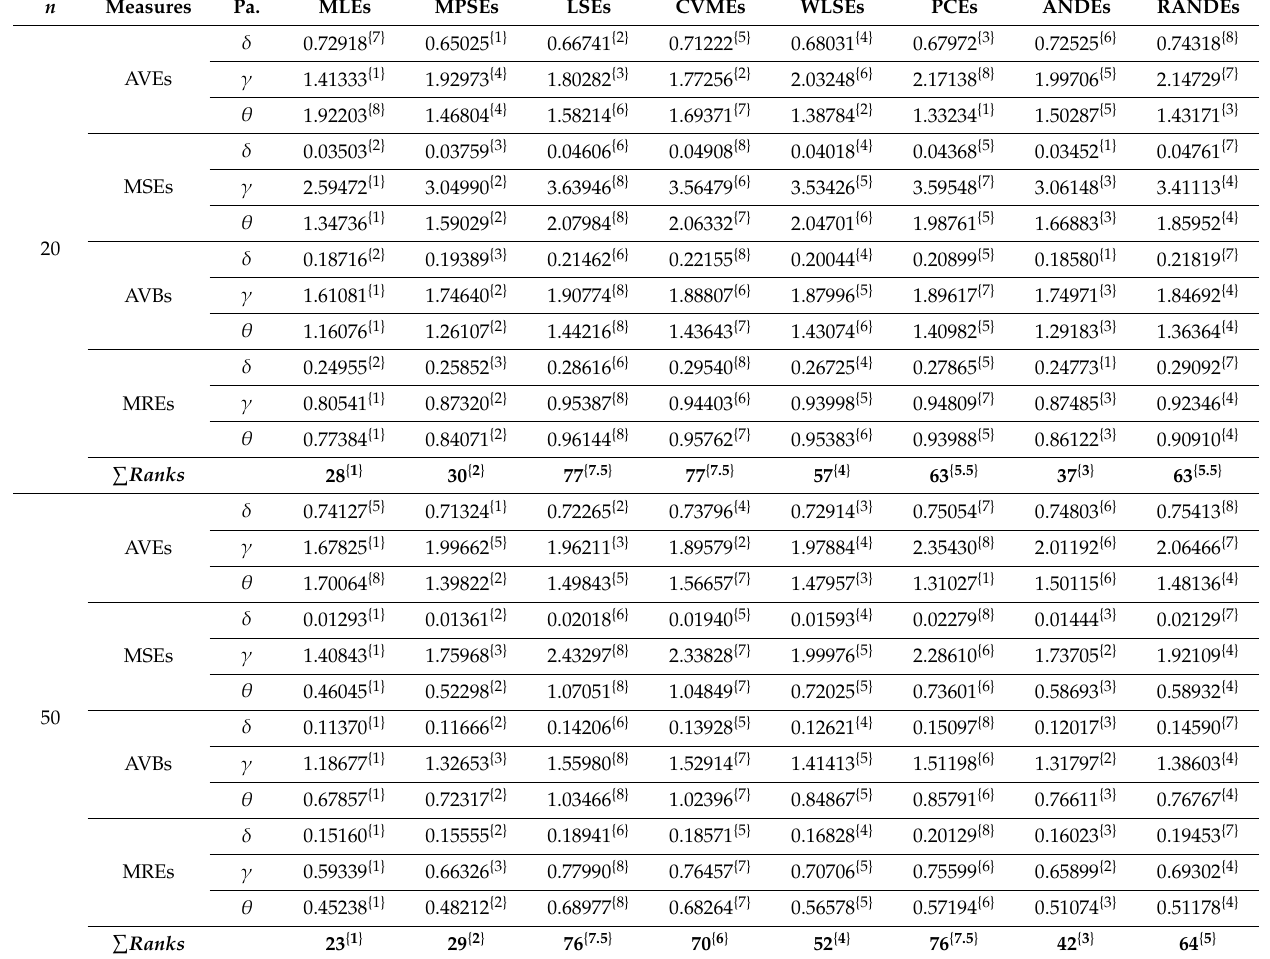
Table A3. Simulation results of several estimation methods for δ = 0.75, γ = 2.00 and θ =